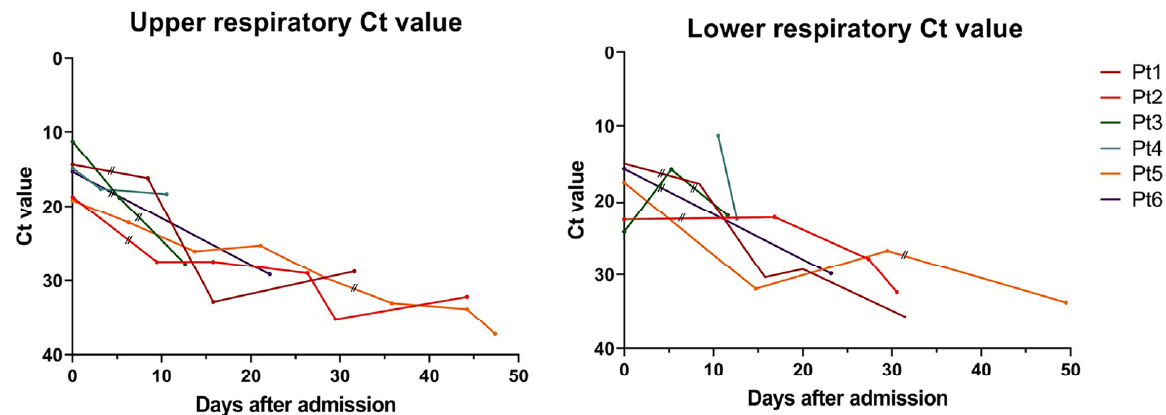
Figure 1. The cycle threshold (Ct) values of SARS-CoV2 detected in patients’ upper ( left , nasopharyngeal) and lower respiratory specimens ( right , expectorate sputum), who underwent hyperimmunoglobulin (GC5131) therapy. A double slash represents the day each patient received the therapy. Patient 4 received the therapy on the 14th day, so the graph does not show the date of medica- tion.